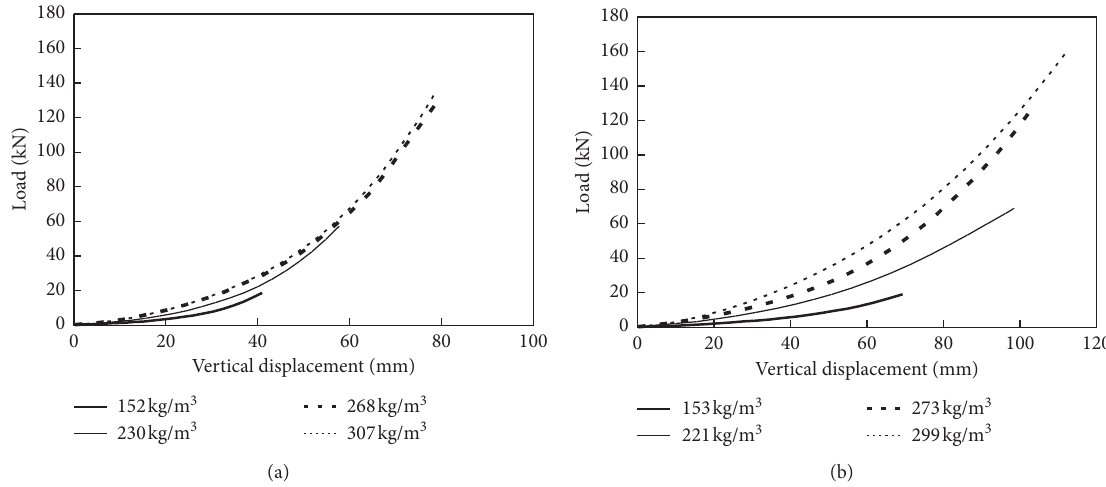
Figure 9: Load–displacement curves for the unplastering straw bales laid flat. (a) Initial volume of 0.04m 3 . (b) Initial volume of 0.06m 3 .